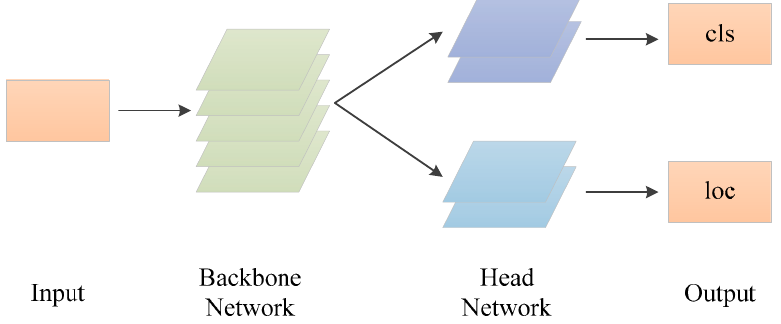
Figure 1. The overall architecture of object detection model. Backbone network extracts features for classification and location tasks, and head network includes two subnetworks extracting unique features for two different tasks. The object detection model will obtain classification and location results.